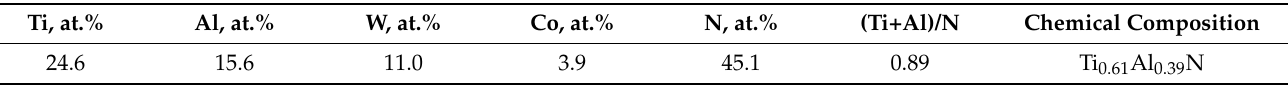
Table 3. Elemental composition of the TiAlN coating deposited by the Al magnetron at 1 kW of power. Ti, at.% Al, at.% W, at.% Co, at.% N, at.% 24.6